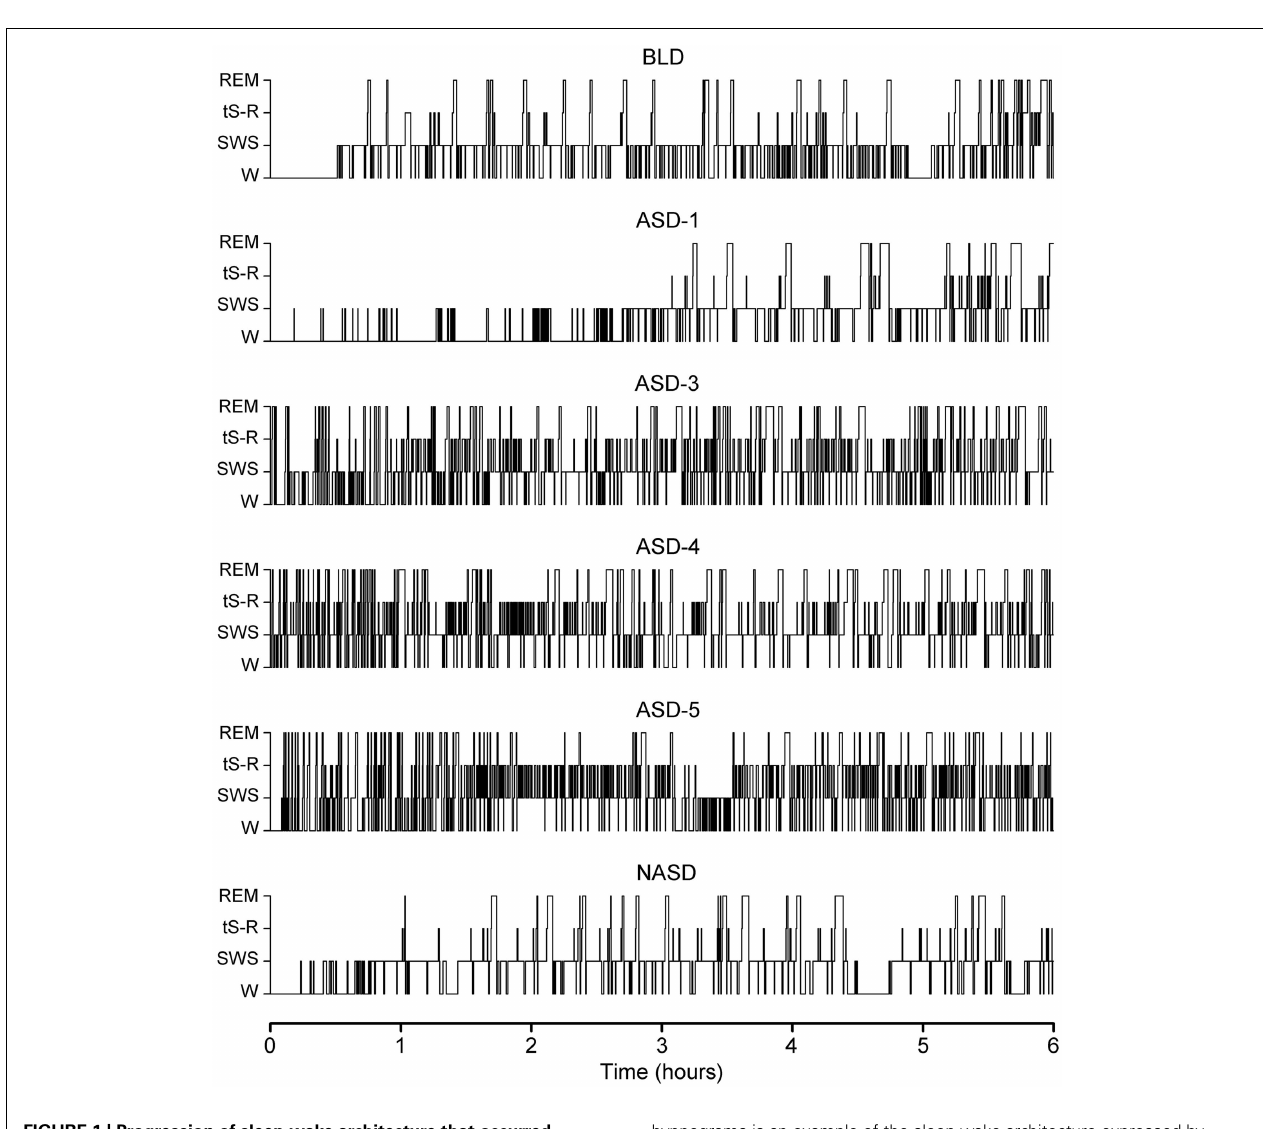
FIGURE 1 | Progression of sleep-wake architecture that occurred over the course of the six experimental test days, listed chronologically: no exposure to anxiogenic stressor (AS) baseline day (BLD), day 1 ofAS exposure (ASD-1), day 3 ofAS exposure (ASD-3), day 4 ofAS exposure (ASD-4), day 5 ofAS exposure (ASD-5), and no exposure toAS day (NASD). Each of the six